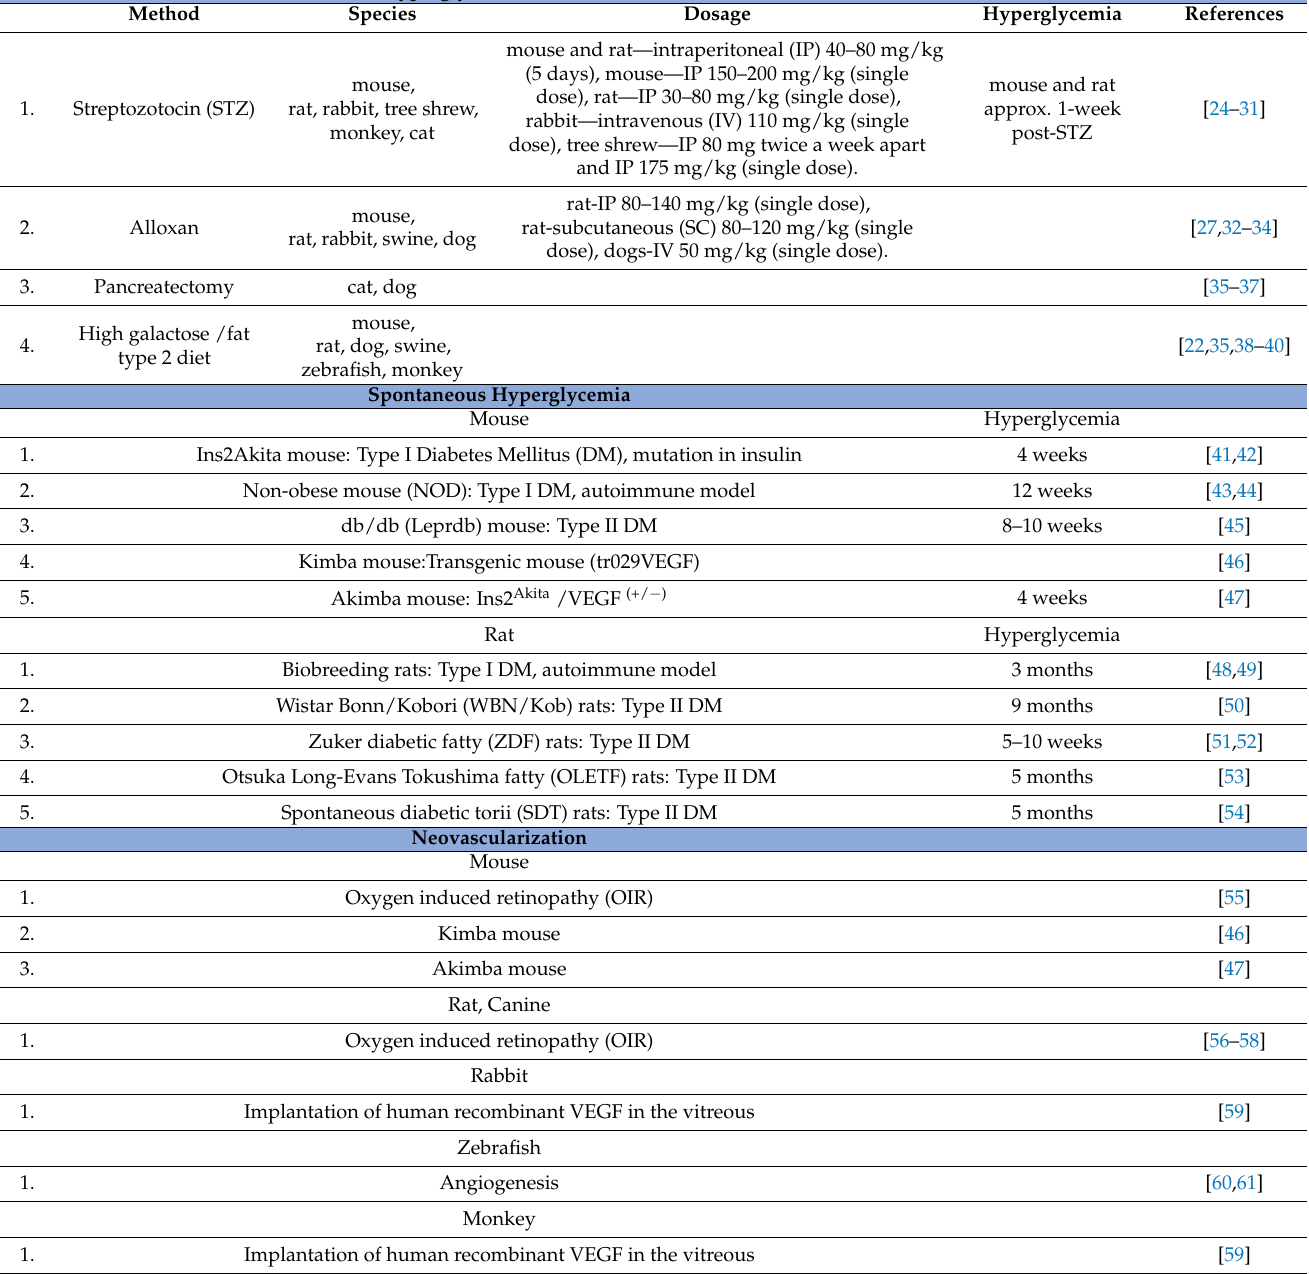
Table 1. Current animal models of diabetic